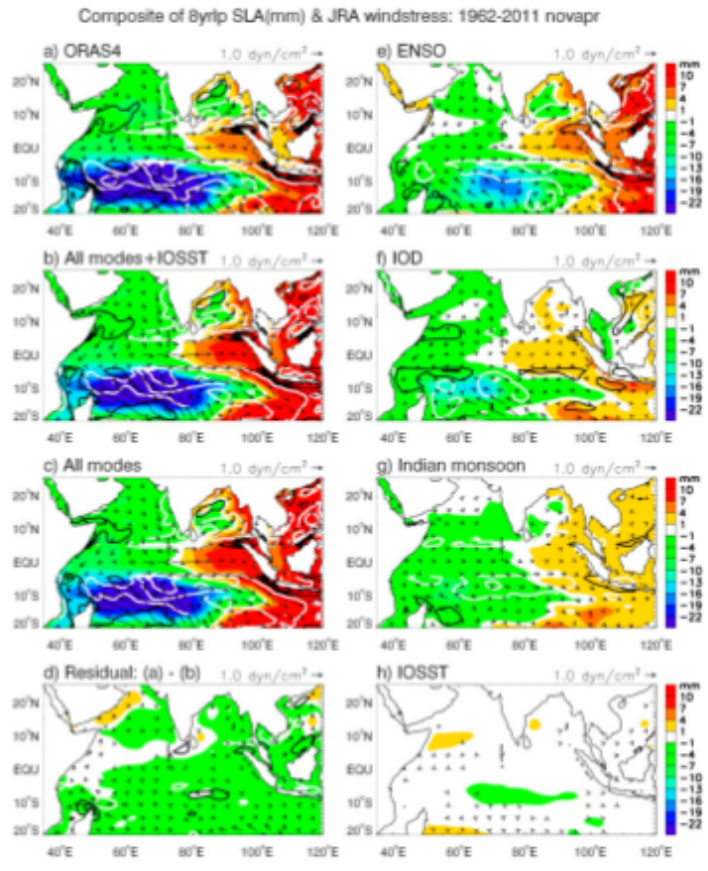
Figure 13. The composite analyses for the November–April mean, 8 year low-passed decadal SLA of November–April mean (color contours), the Japan Meteorological Agency 55-year Reanalysis (JRA55) surface wind stress (arrows; units: × 0.2 dyn cm − 2 ), and the Ekman pumping velocity, w e (line contours, positive (negative) values are in white (black), beginning at 1 ( − 1) with an interval of 2; zero contours are omitted; units: × 10 − 7 m s − 1 ), based on the years when the magnitudes of the ORAS4 decadal SLA in the thermocline ridge area (Reg. 1 of Figures 6–10) exceeded the − 0.5 STD line shown in Figure 11a for: ( a ) the total SLA and wind anomalies; ( b ) the sum of the DLM results from all modes plus IOSST; ( c ) the sum of the DLM results from all modes; ( d ) the residual, which is panel ( a ) minus panel ( b ); ( e – h ) are the same as ( c ) but for the individual mode ENSO, IOD, monsoon, and IOSST, respectively. Note that the w e values within 5 ◦ S–5 ◦ N are not